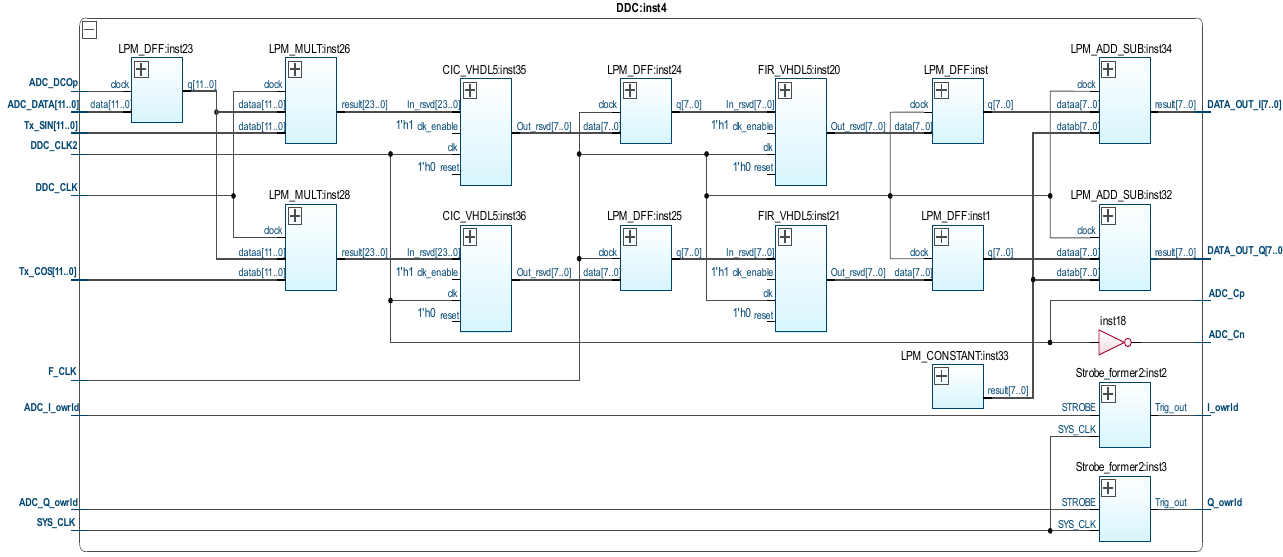
Figure 6. Configuration structure of digital receiver based on FPGA.